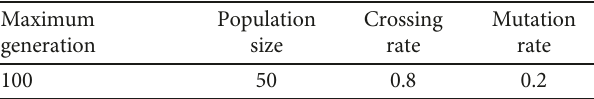
Table 1: Parameters used in